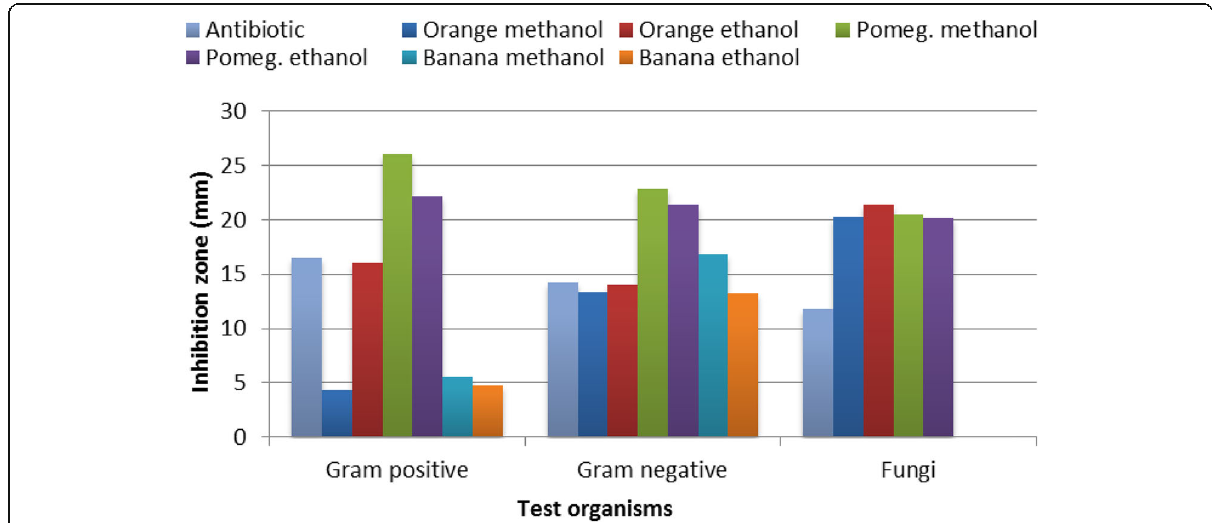
Fig. 1 Antimicrobial activities of the used fruit peel extracts